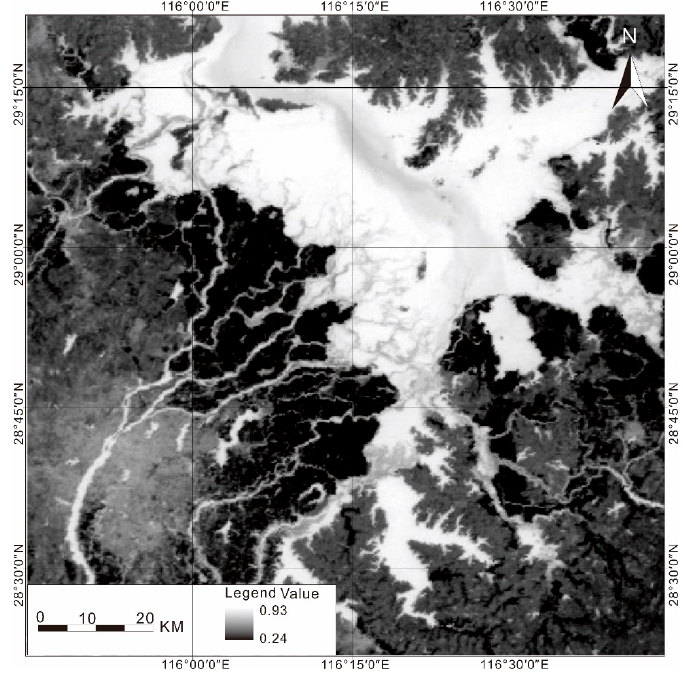
Figure 4. Water probability (normalized difference water index (NDWI)) map of the Poyang Lake area.